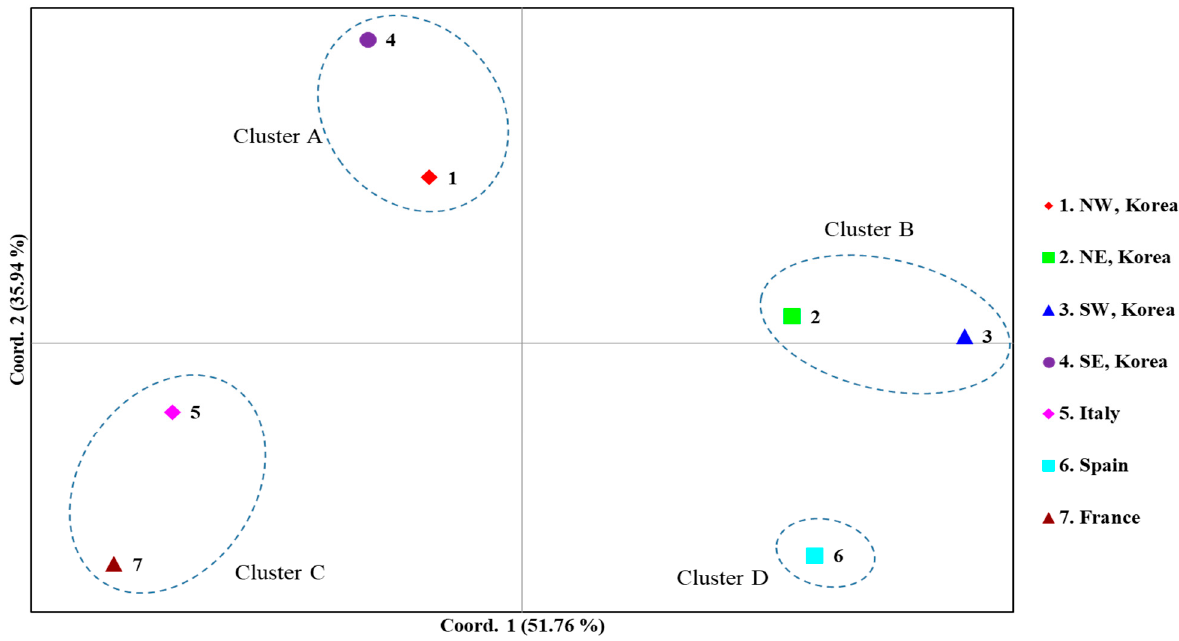
Figure 6. Results of principal coordinates analysis (PCoA) based on country/Korean region using the concatenated sequences of the DNA barcoding region (658 bp) and Region 5. The percentages of variation explained by the first and second axes are indicated.